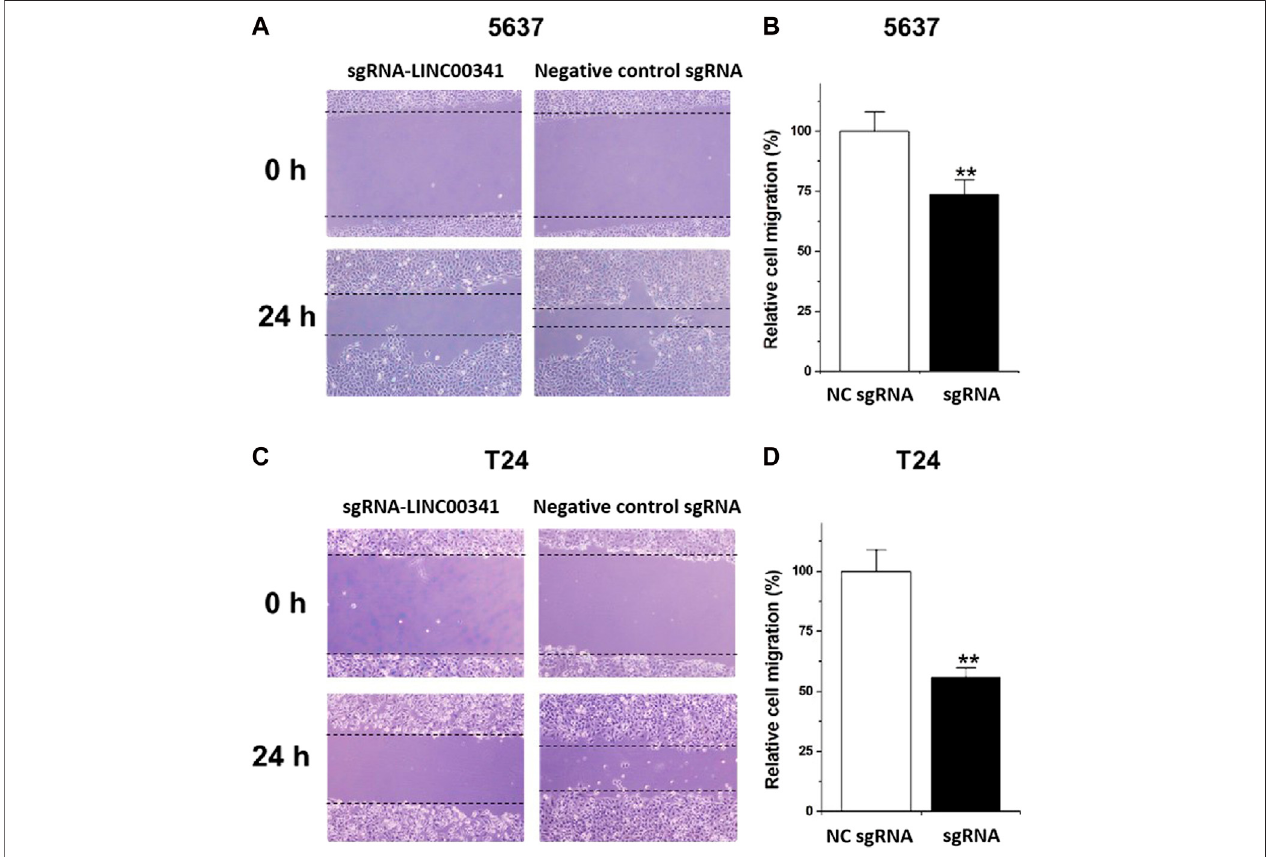
FIGURE 4 | Knockdown of LINC00341 by CRISPR-CasRx decreased cell motility. Following the transfection with LINC00341 sgRNA or the negative control sgRNA,weperformedthewoundhealinganalysistoexplorethecellmotilityalterationsinT24aswellas5,637cells. (A) .Woundhealingassayillustrativeimagesin5,637 cells. (B) . Diminished cell motility was seen in 5,637 cells (** p < 0.01). (C) . Wound healing assay illustrative images of T24 cells. (D) . Diminished cell motility occurred in T24 cells (** p < 0.01). Data are indicated as mean ± SD. The experiments were conducted in triplicates for three independent times for both cell